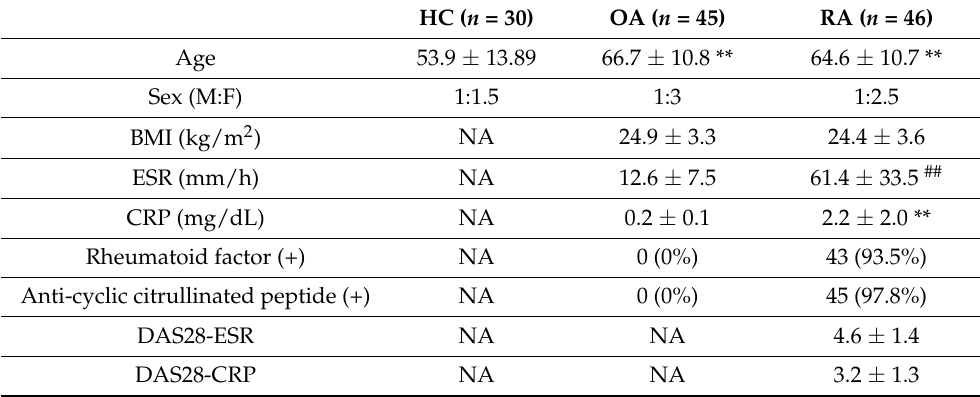
Table 1. General characteristics of healthy controls and patients with osteoarthritis or rheuma- toid